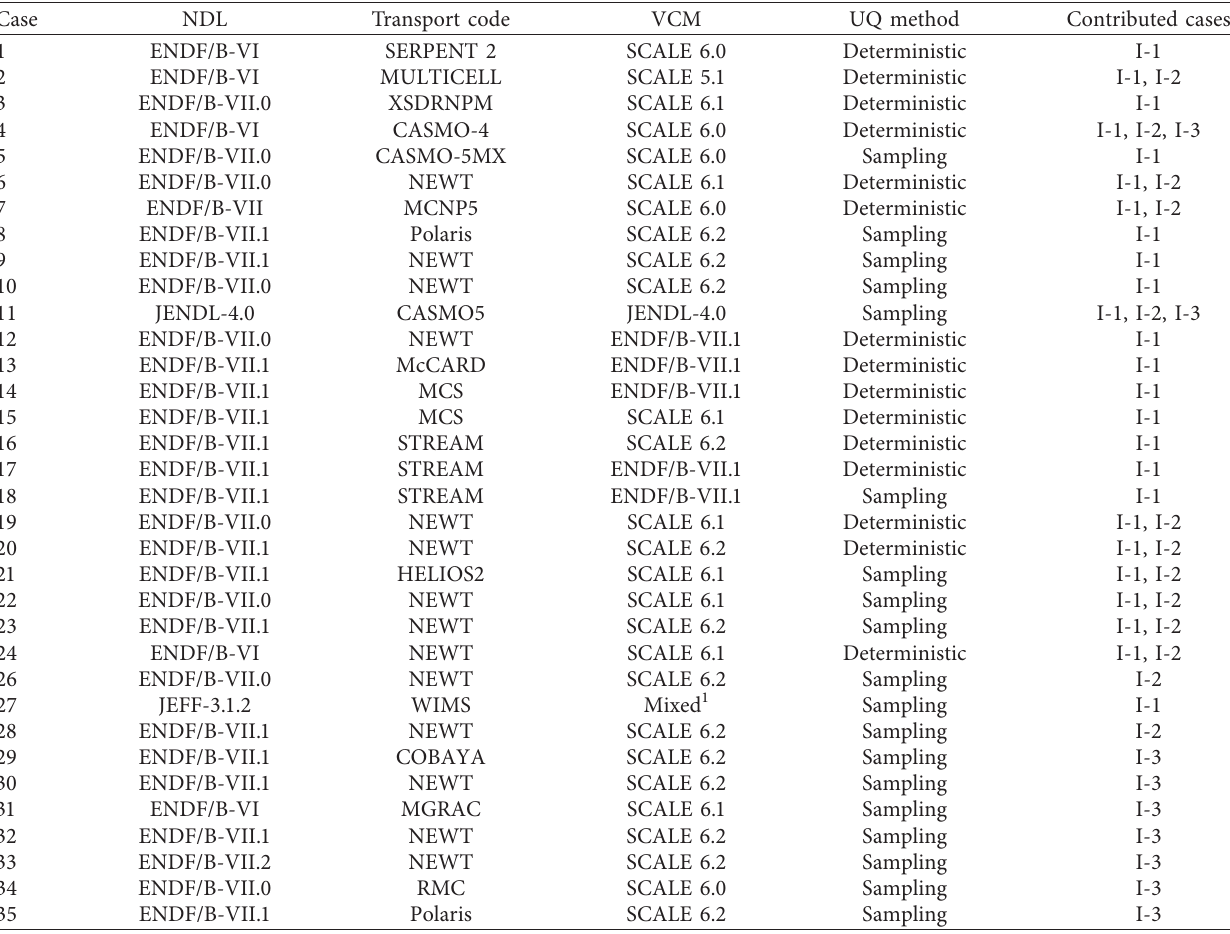
Table 1: Summary of submitted results of stand-alone neutronics cases.